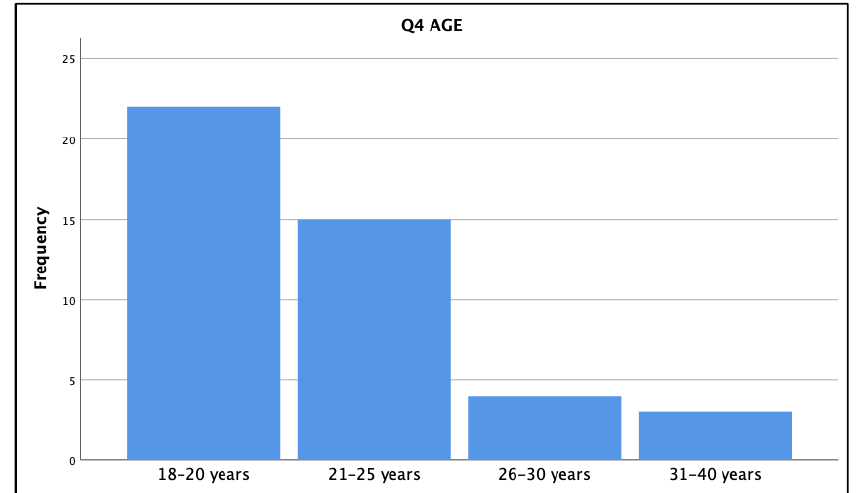
Figure 1. BScN Collaborative Program survey participants ( n = 44) by age bracket.